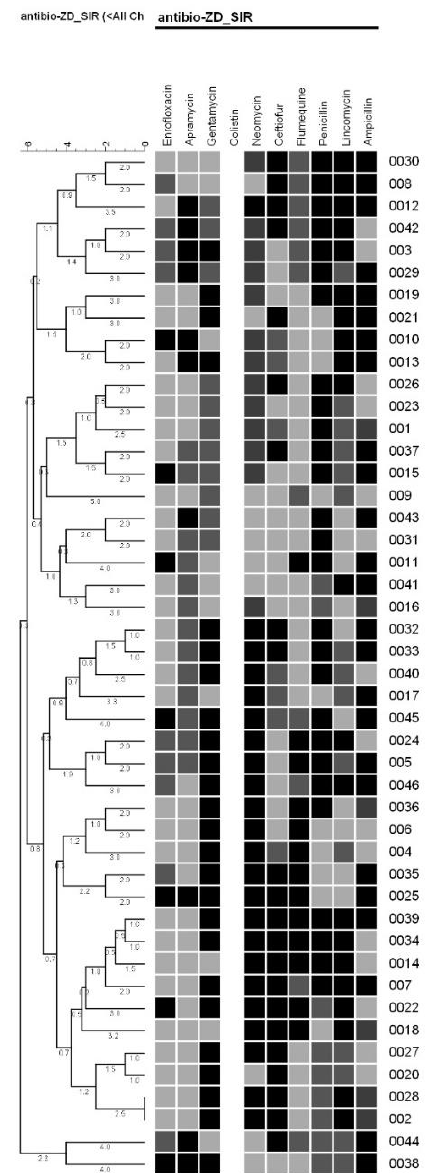
Figure 2. Resistance profile cluster analysis of gram-negative isolates. Black, gray, and white colors correspond to resistance, intermediate, and sensitivity to antimicrobials, respectively.